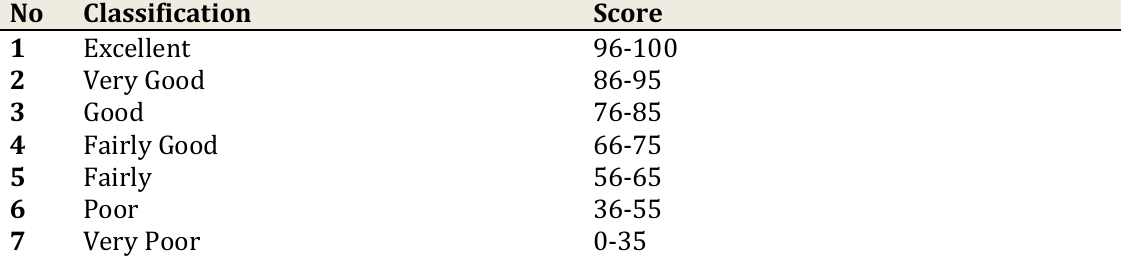
Table 3.2 Scoring classification using in